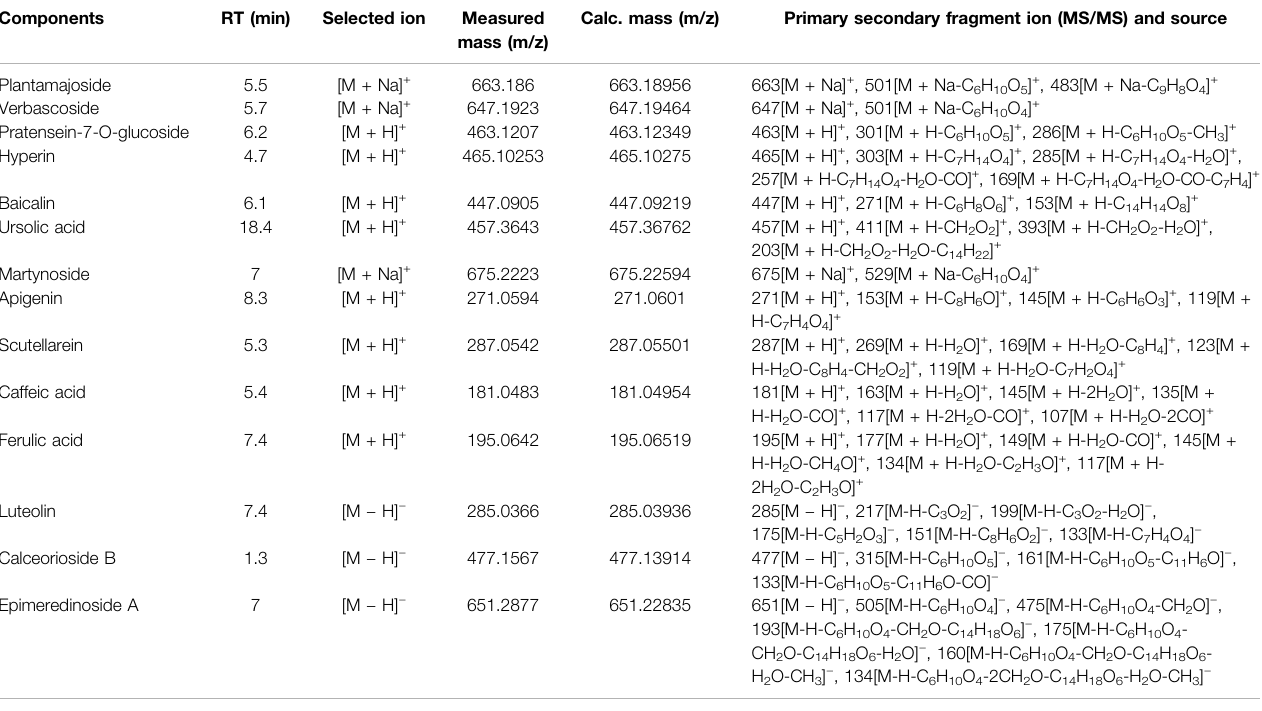
TABLE 2 | UPLC-Q-TOF/MS of two effective parts containing ethyl acetate and remaining parts of P. asiatica . Components